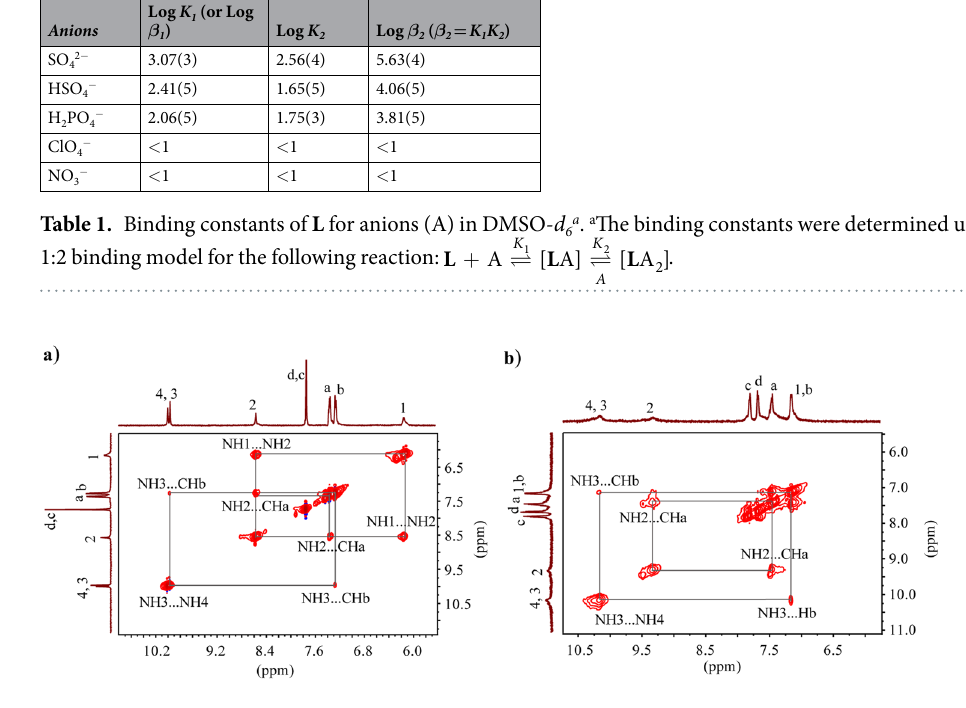
Figure 4. 2D NOESY NMR experiment of ( a ) Free L , and ( b ) L in the presence of one equivalent of sulfate anion in DMSO- d 6 at room